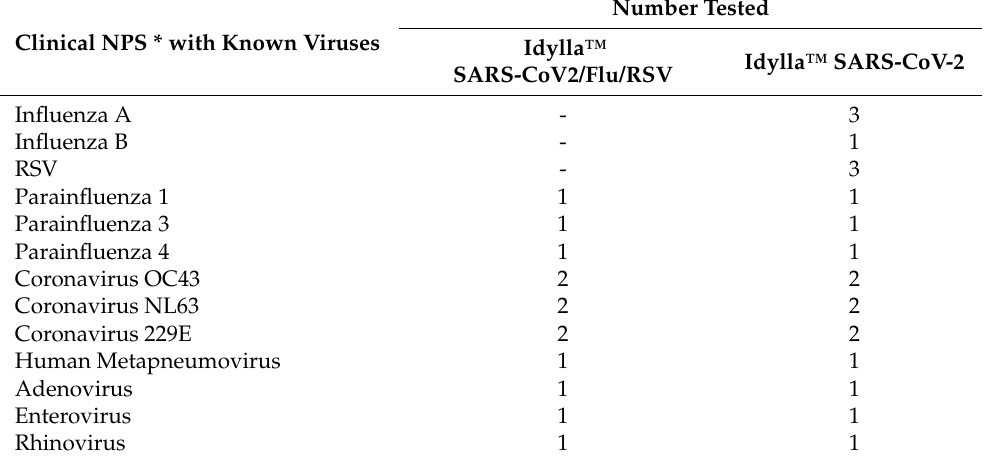
Table 3. Panel of commonly found respiratory viruses in respiratory infections used for the evaluation of